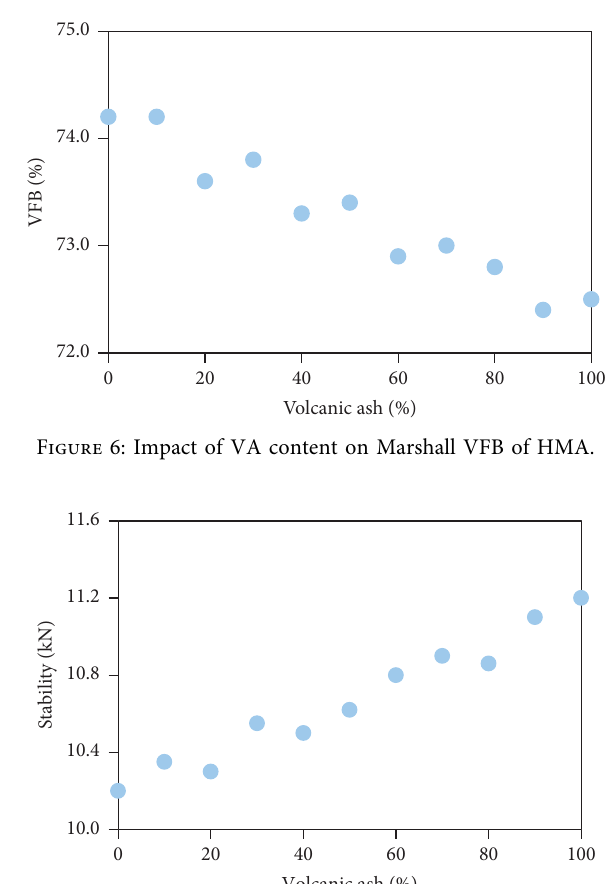
Figure 10: Impact of VA content on tensile strength ratio of